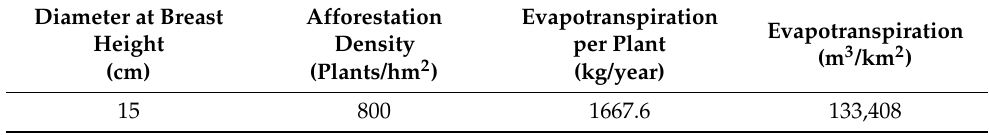
Table 2. Annual evapotranspiration of Acer